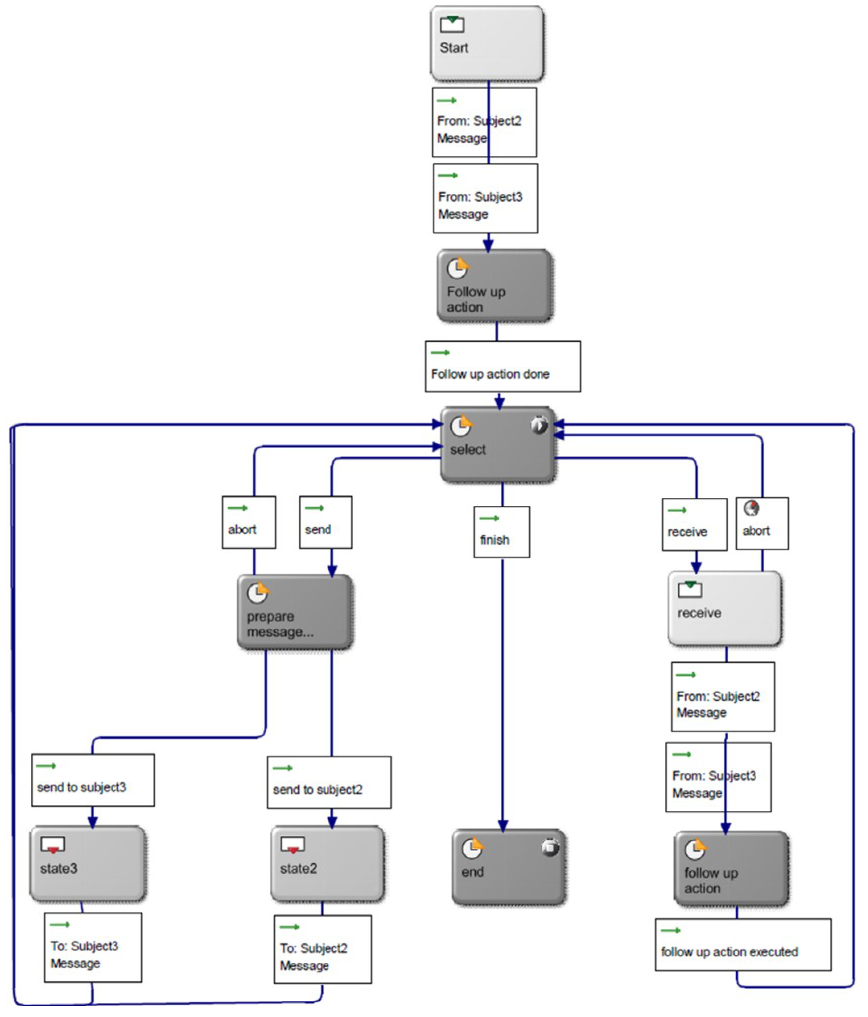
Figure 7. Generic behavior of Subject1 that starts the